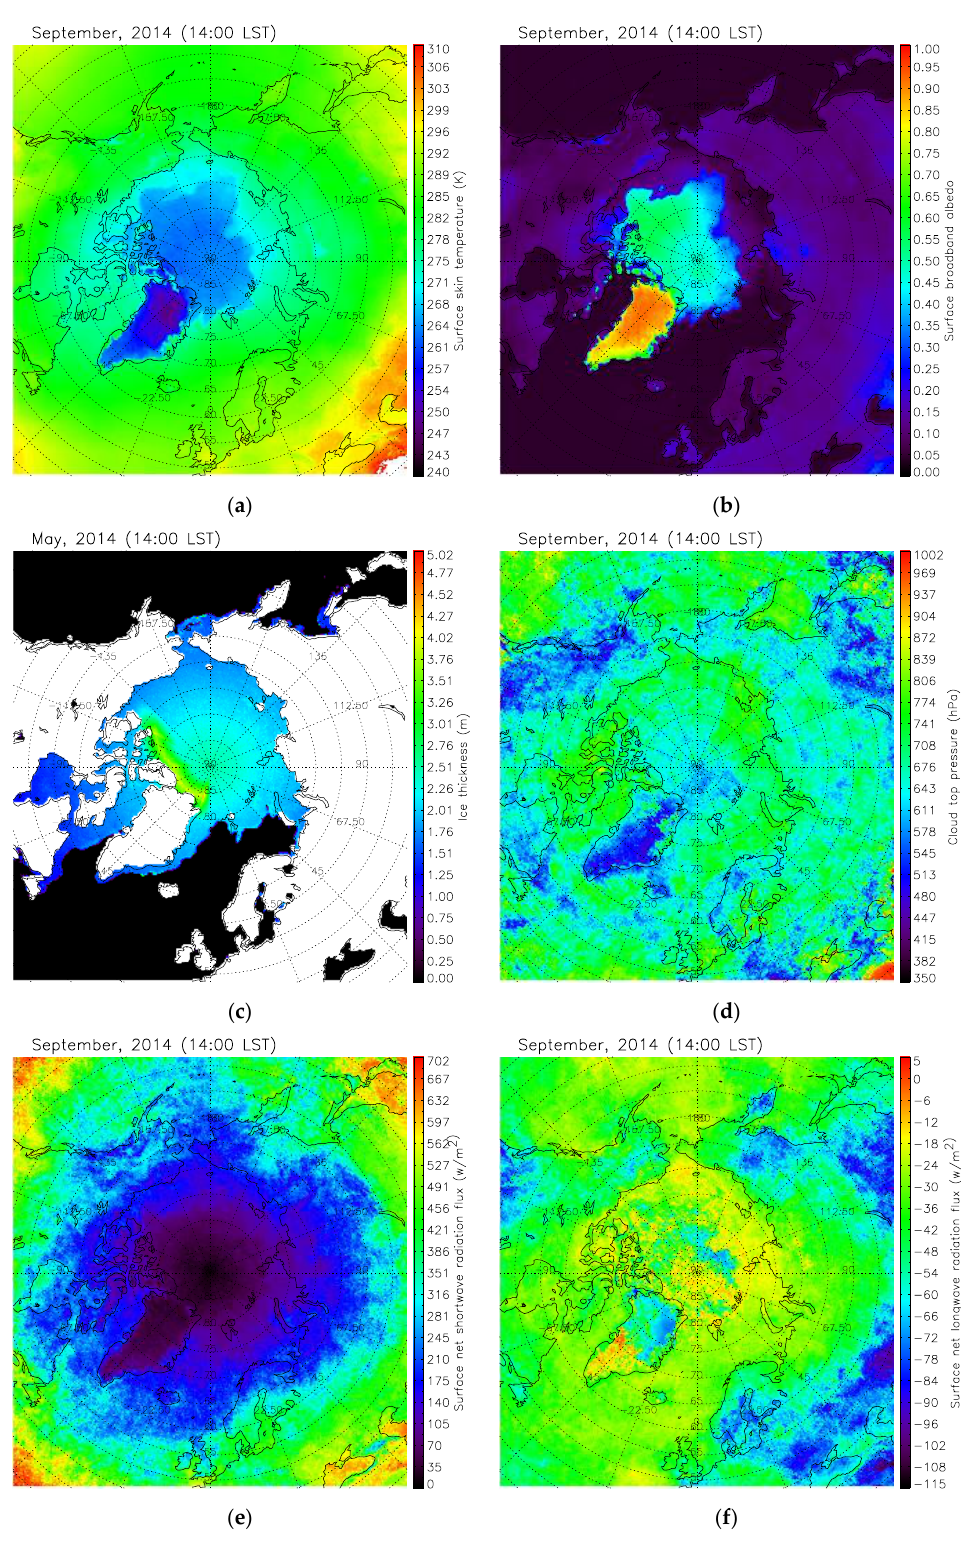
Figure 5. Examples of some APP-x variables over the Arctic. Monthly means are for September 2014 except for sea ice thickness, which is May 2014. Shown are surface skin temperature ( a ), surface broadband albedo ( b ), sea ice thickness ( c ), cloud top pressure ( d ), surface net shortwave radiative flux ( e ), and surface net longwave radiative flux ( f